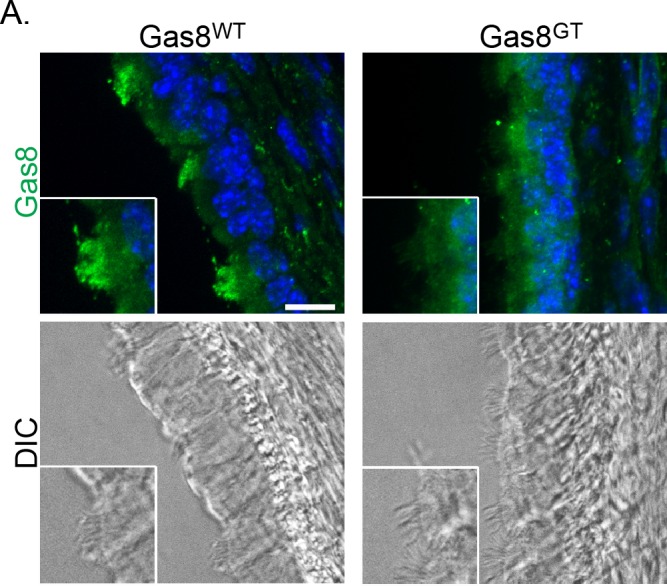
Gas8 localizes to cilia.Gas8 immunofluorescence staining on Gas8WT and Gas8GT p21 trachea (Scale Bar = 10μm). Gas8 is present in wild-type axonemes but absent from mutant axonemes. DIC images are shown to visualize the cilia on the tracheal epithelium.